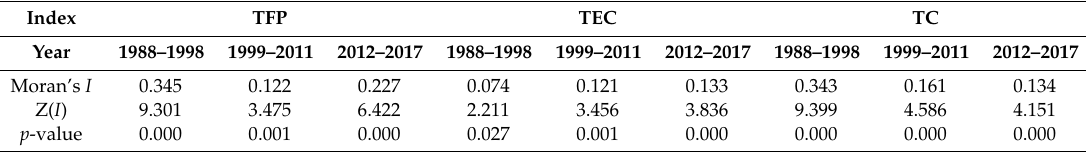
Table 3. Global Moran’s I of agricultural TFP , TEC , and TC in Gansu Province.